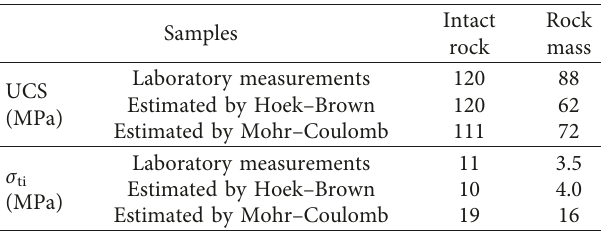
Table 4: Comparison between Hoek–Brown criterion and Mohr–Coulomb